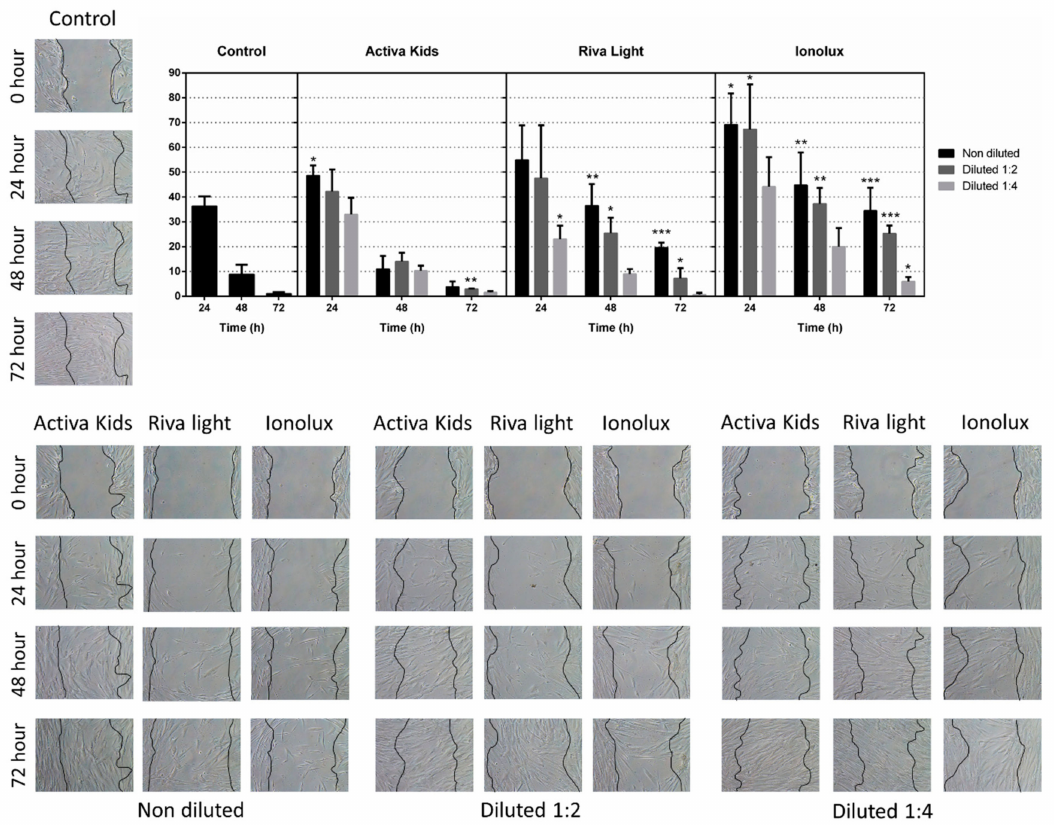
Figure 3. In vitro wound-healing assay. The healing process was allowed to proceed in the presence of the di ff erent material eluates, or without eluates (control group). The wound closure was evaluated at 24 h, 48 h, and 72 h. It was performed with three replicates. Data are expressed as fold of the control group (considered as 100%). Cell migration di ff erences are shown as * p < 0.05; ** p < 0.01; *** p <